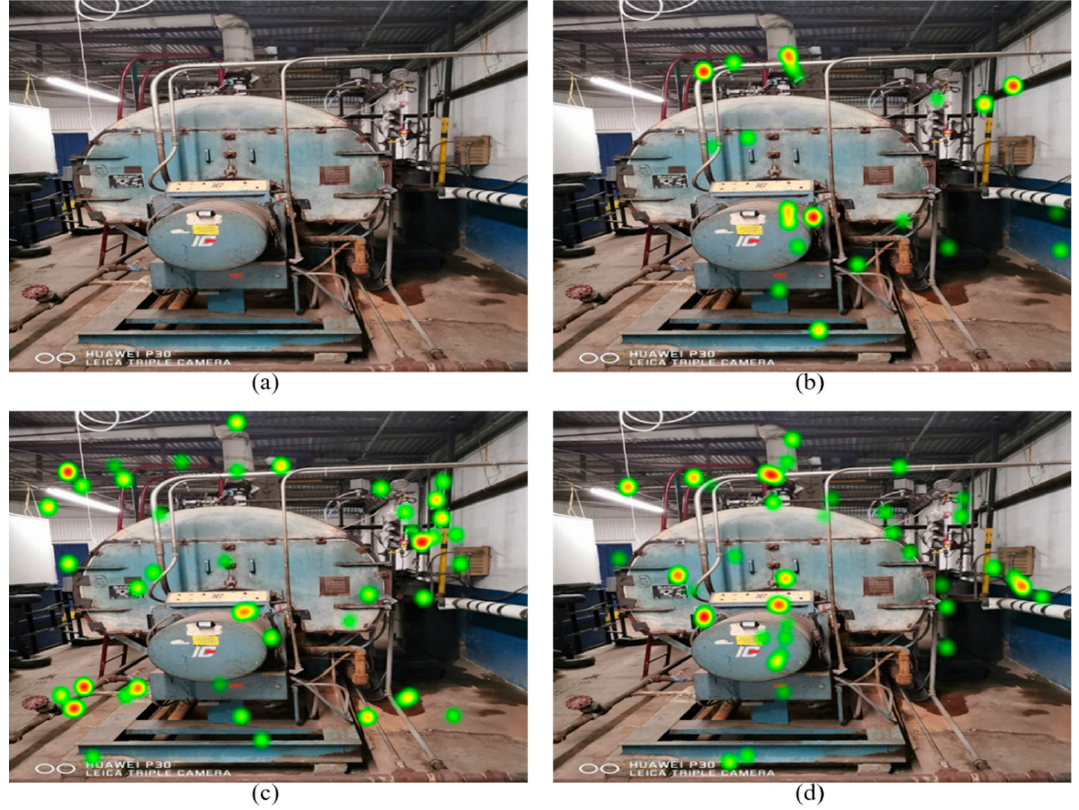
Figure 4. Attentional distribution (heat map): ( a ) original image; ( b ) participant before receiving the in-class training; ( c ) participant after receiving the in-class training; ( d ) experienced